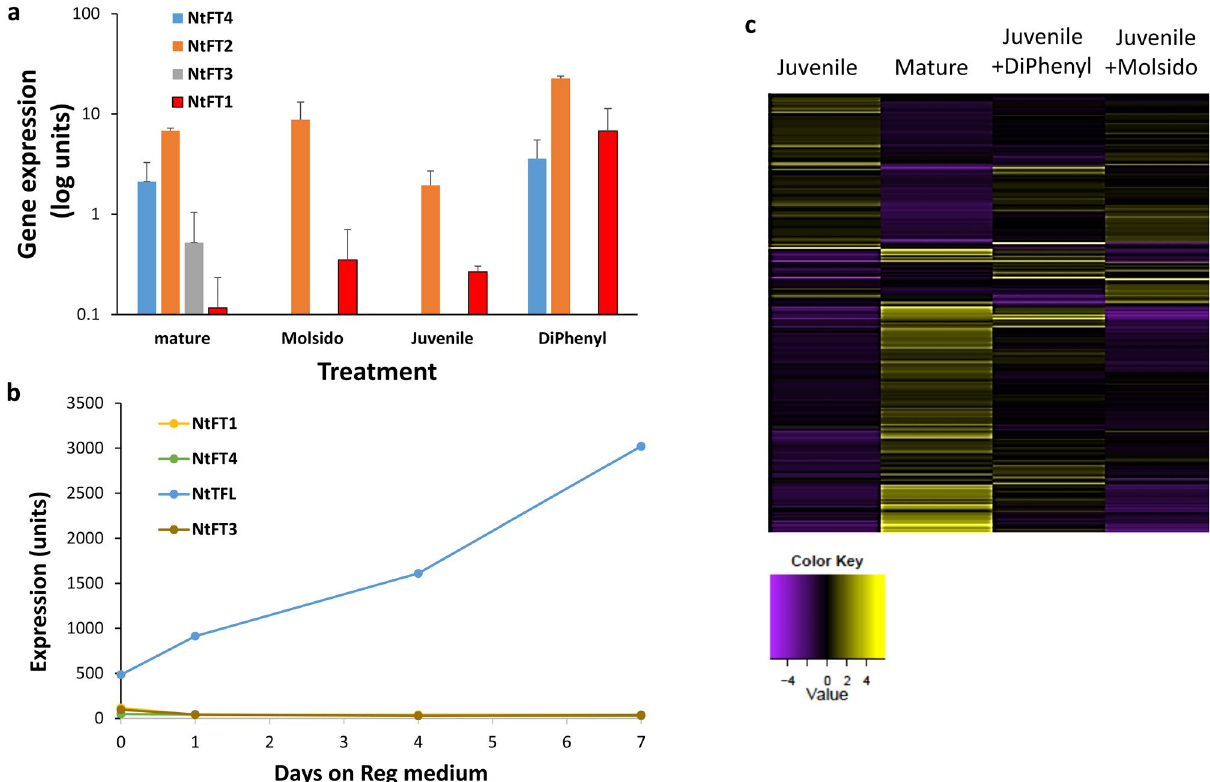
Figure 3. Effect of treatment with Nitric Oxide donor or inhibitor or leaf age on tobacco FLOWERING LOCUS T gene family expression. ( a ) The expression level of tobacco FLOWERING LOCUS T gene family at the juvenile, mature, juvenile leaf treated with DiPhenyl and juvenile leaf treated with Molsido. Tobacco seedlings at the cotyledon stage were transferred and grown on an agar medium supplemented with 2% sucrose and 5 µM DiPhenyl or 5 µM Molsido. Gene expression was tested in leaves number 7 as juvenile and 20 as mature grown in a sterile condition. mRNA levels of the FLOWERING LOCUS T gene family are expressed as log units. ( b ) Expression level of tobacco FLOWERING LOCUS T gene family during the seven days induction period of shoots on Reg medium. ( c ) Visualisation by heatmap of genes whose mRNA expression increase or decreases at the juvenile, mature, juvenile leaf treated with DiPhenyl and juvenile leaf treated with